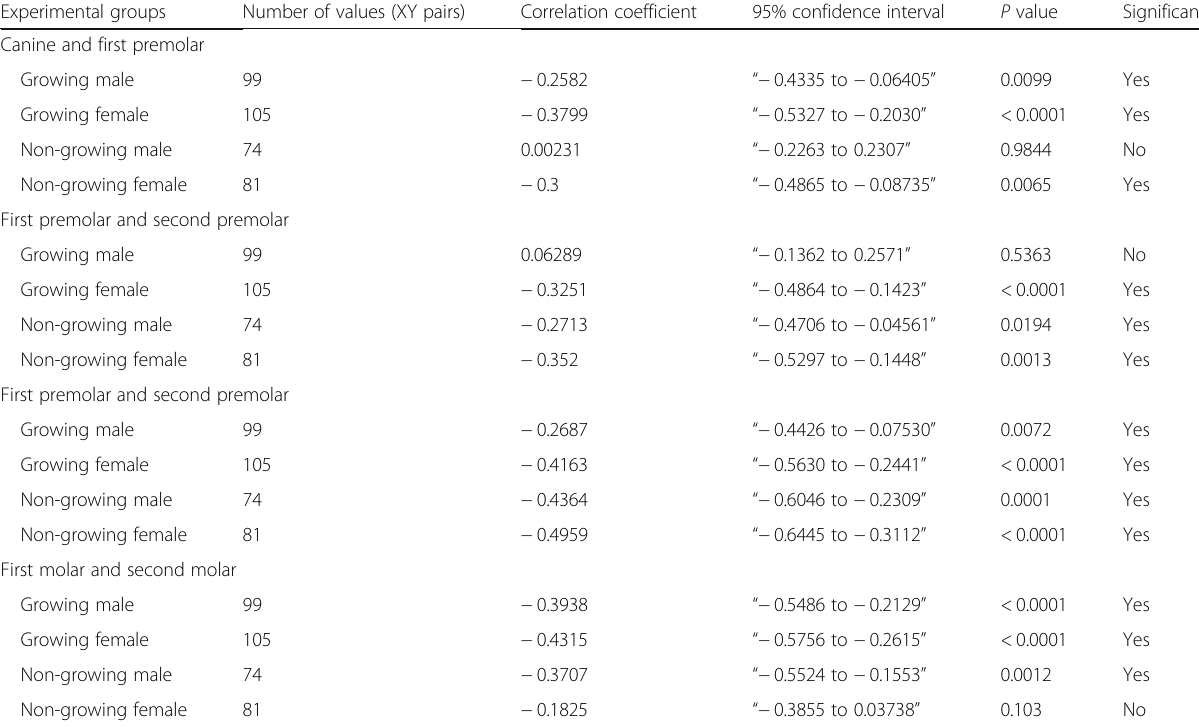
Table 5 Correlation between palatal bone thickness and palatal bone density in different groups Experimental